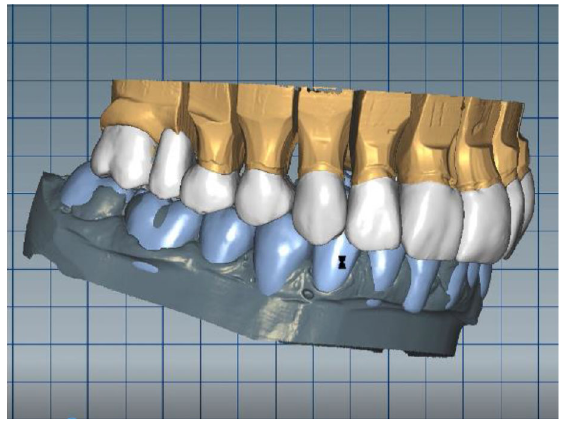
Figure 9. Digital design on both